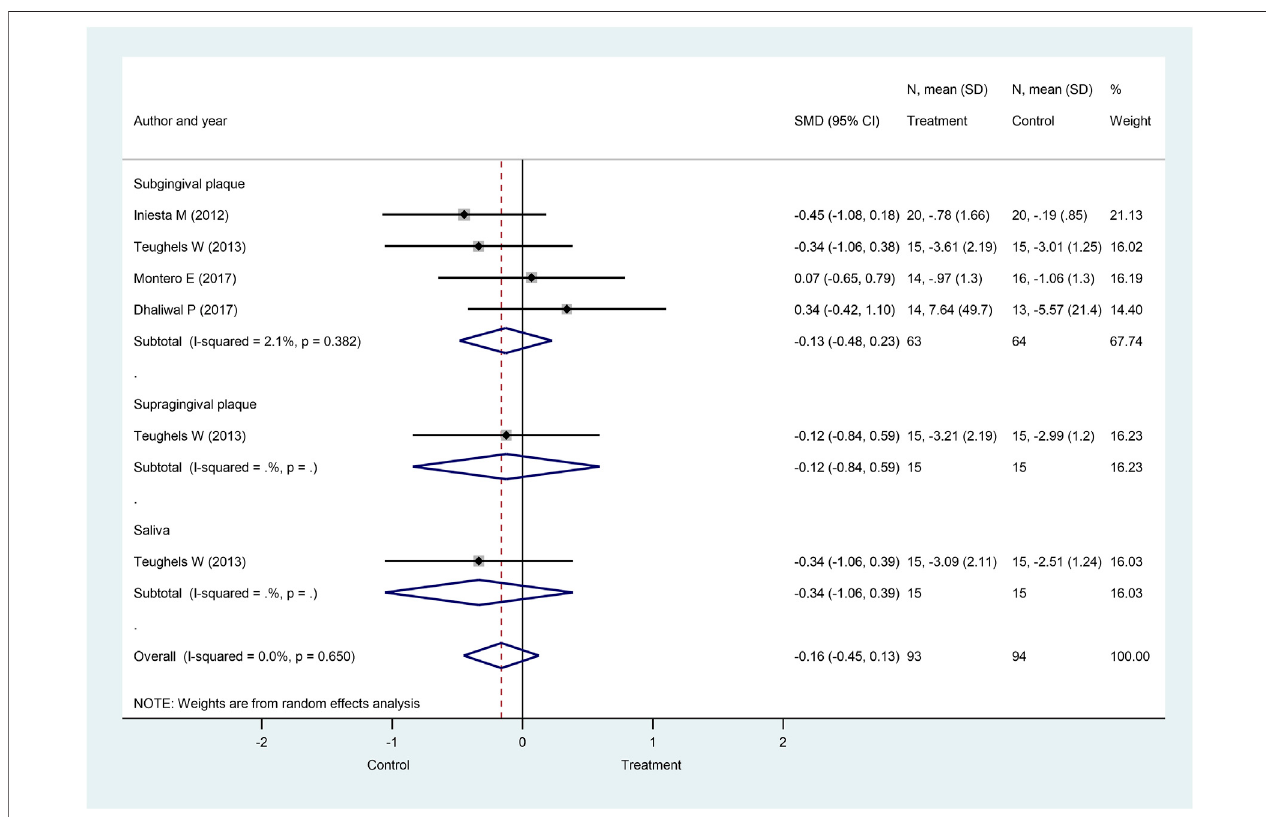
FIGURE 4 | Forest plot analysis of the change in Aggregatibacter actinomycetemcomitans at 8 weeks. The overall result presented no signi fi cant difference of bacterial decrease when both treatment and control groups were compared (SMD: − 0.16; 95% CI: − 0.45 – 0.13; p (cid:2) 0.271).